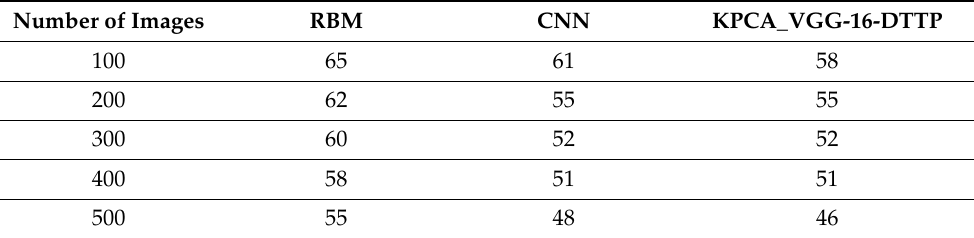
Figure 6. Comparison of RMSE. 9. Discussion